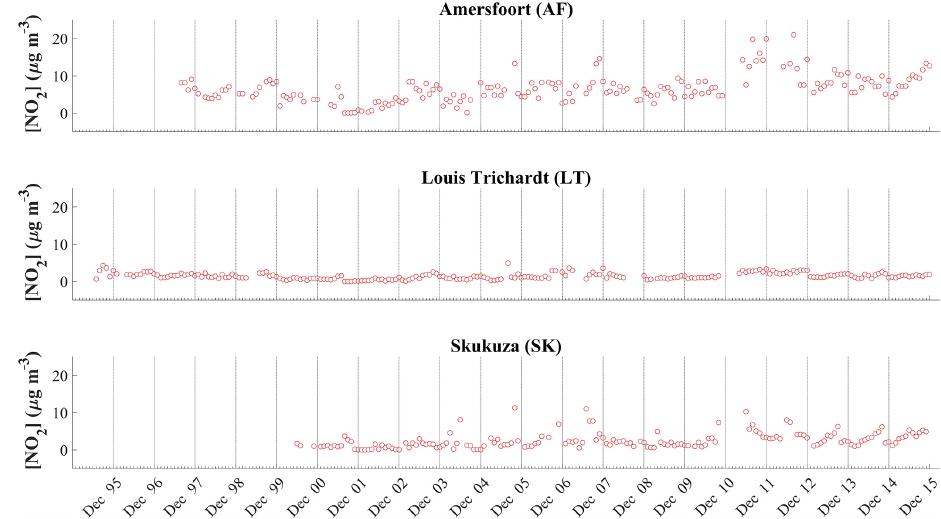
Figure A2. Time series of monthly average NO 2 concentrations measured at Amersfoort (AF), Louis Trichardt (LT) and Skukuza (SK) using passive samplers over the relevant measurement